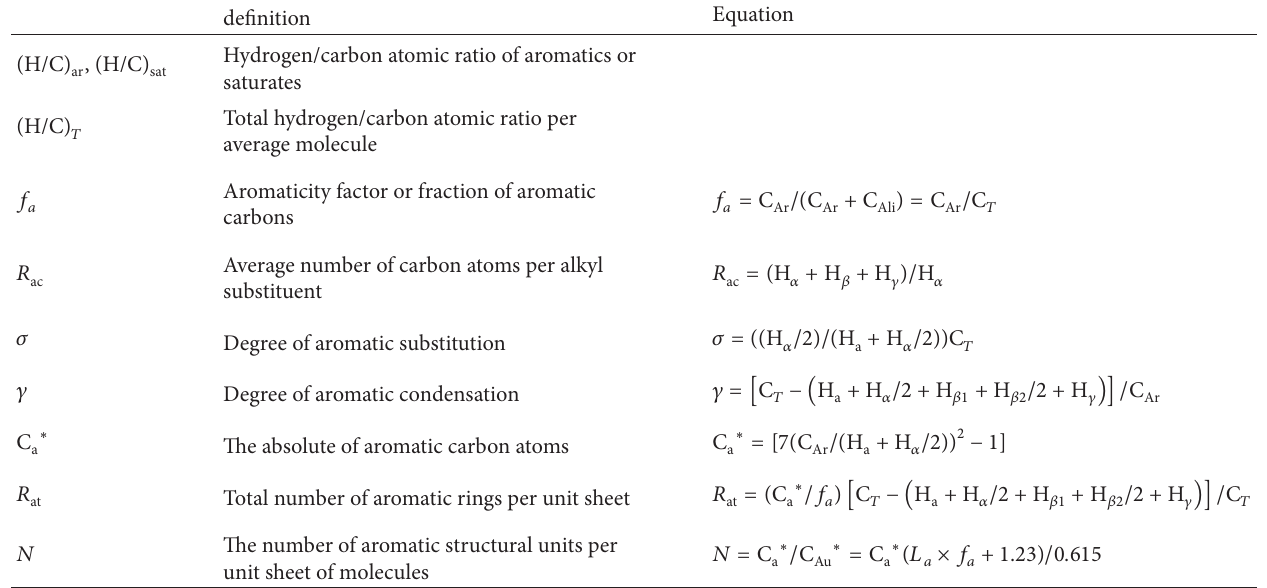
Table 4: Definition of average structural parameters.